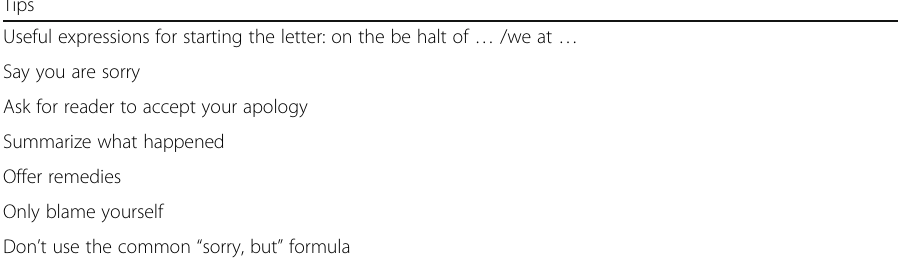
Table 5 Scoring rubric for business apology letters (minor